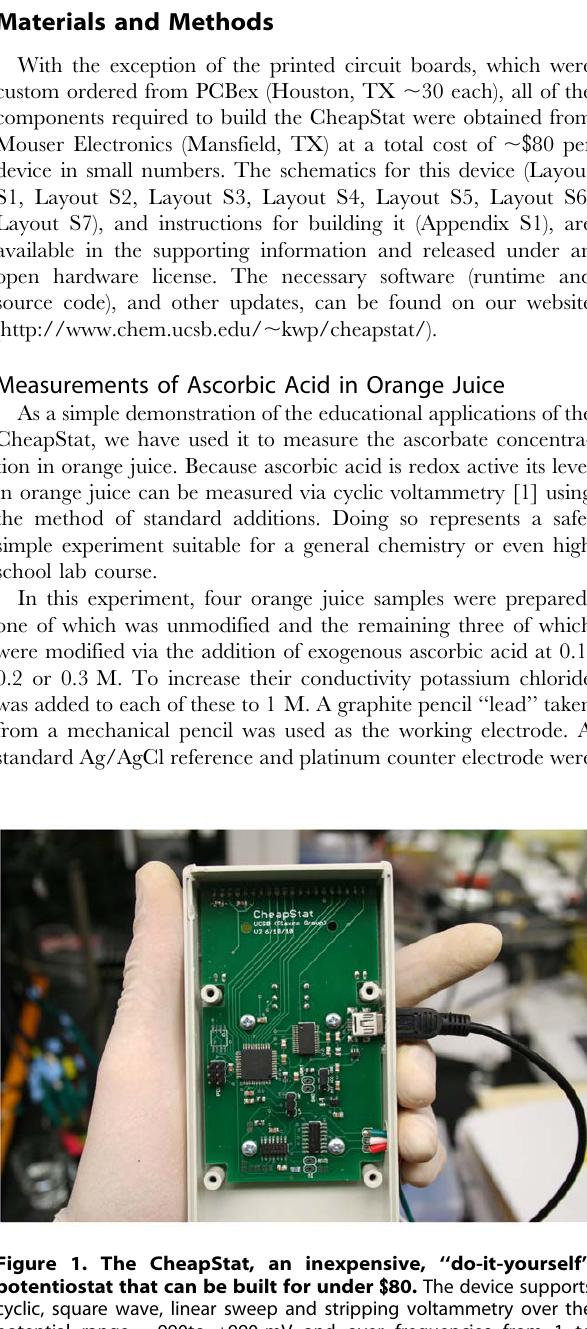
( Figure 1 ), an open-source potentiostat easily constructed by